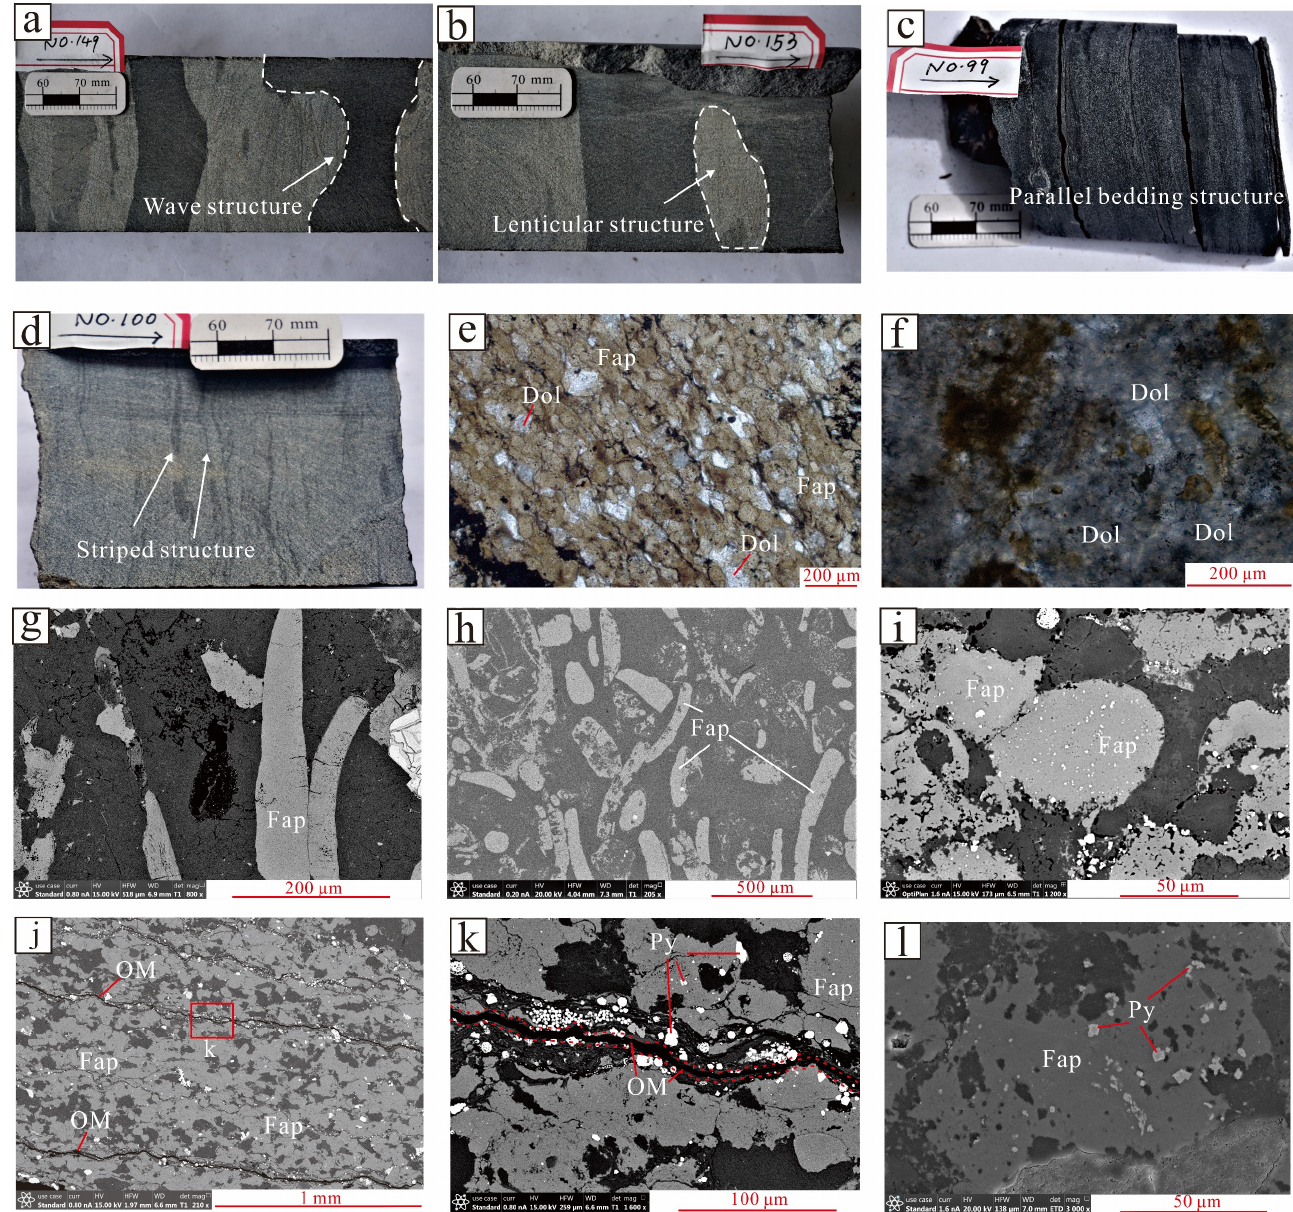
Figure 3. Characteristics of specimens and minerals from Zhijin phosphorites, South China. ( a ) Wave structure. ( b ) Lenticular structure. ( c ) Parallel bedding structure. ( d ) Striped structure. ( e ) Transmissive light from polarizing microscope: Dolomite cements between fluorapatites. ( f ) Trans-